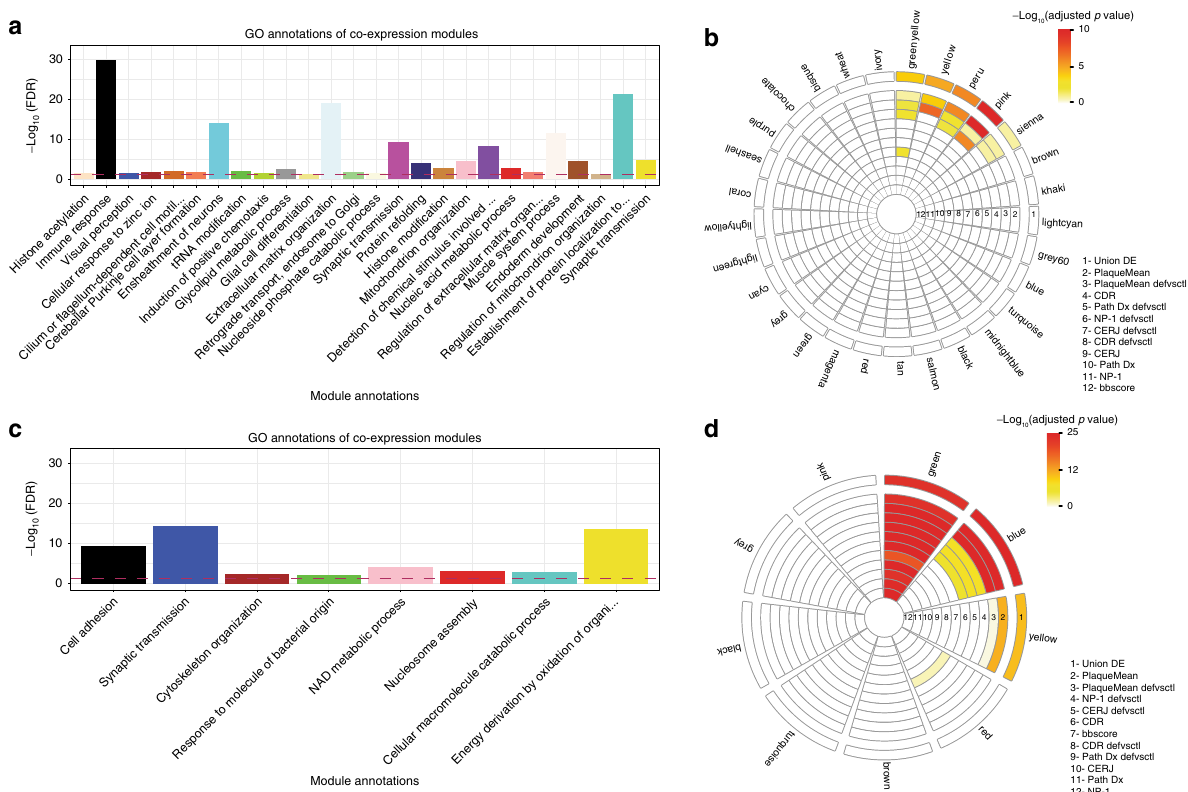
Fig. 3 Co-expression network analyses. a , c Top GO annotations for gene ( a ) and protein ( c ) co-expression modules. The x - and y -axis represent the best GO term associated with each module and the − log 10(FDR) of the enrichment, respectively. The color of the bars represents the module names. In bold are the four modules enriched for genes in the union of the DE signatures. b , d Module enrichments for DE genes ( b ) and proteins ( d ). The circos plot depicts the enrichment of each module for DE genes or proteins; the “ hotness ” of the color represents the magnitude of the − log 10(adjusted p value) of the enrichment for the corresponding signature list. The traits are de fi ned as 1 through 12; in bold are the modules enriched for the union of the DE